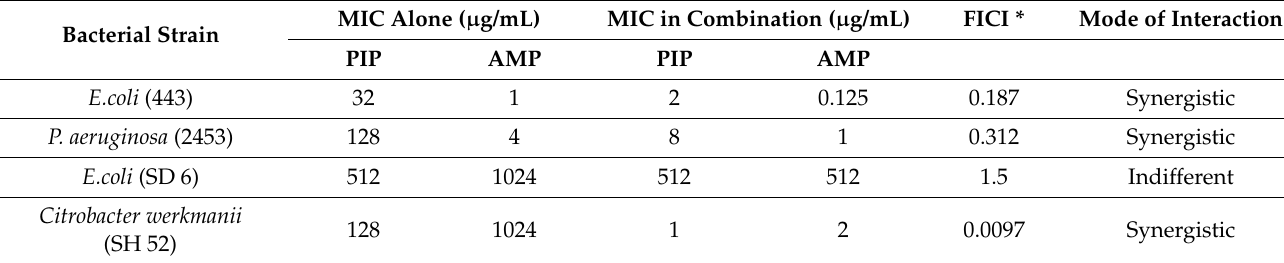
Table 3. Synergistic antibacterial activity of PIP with